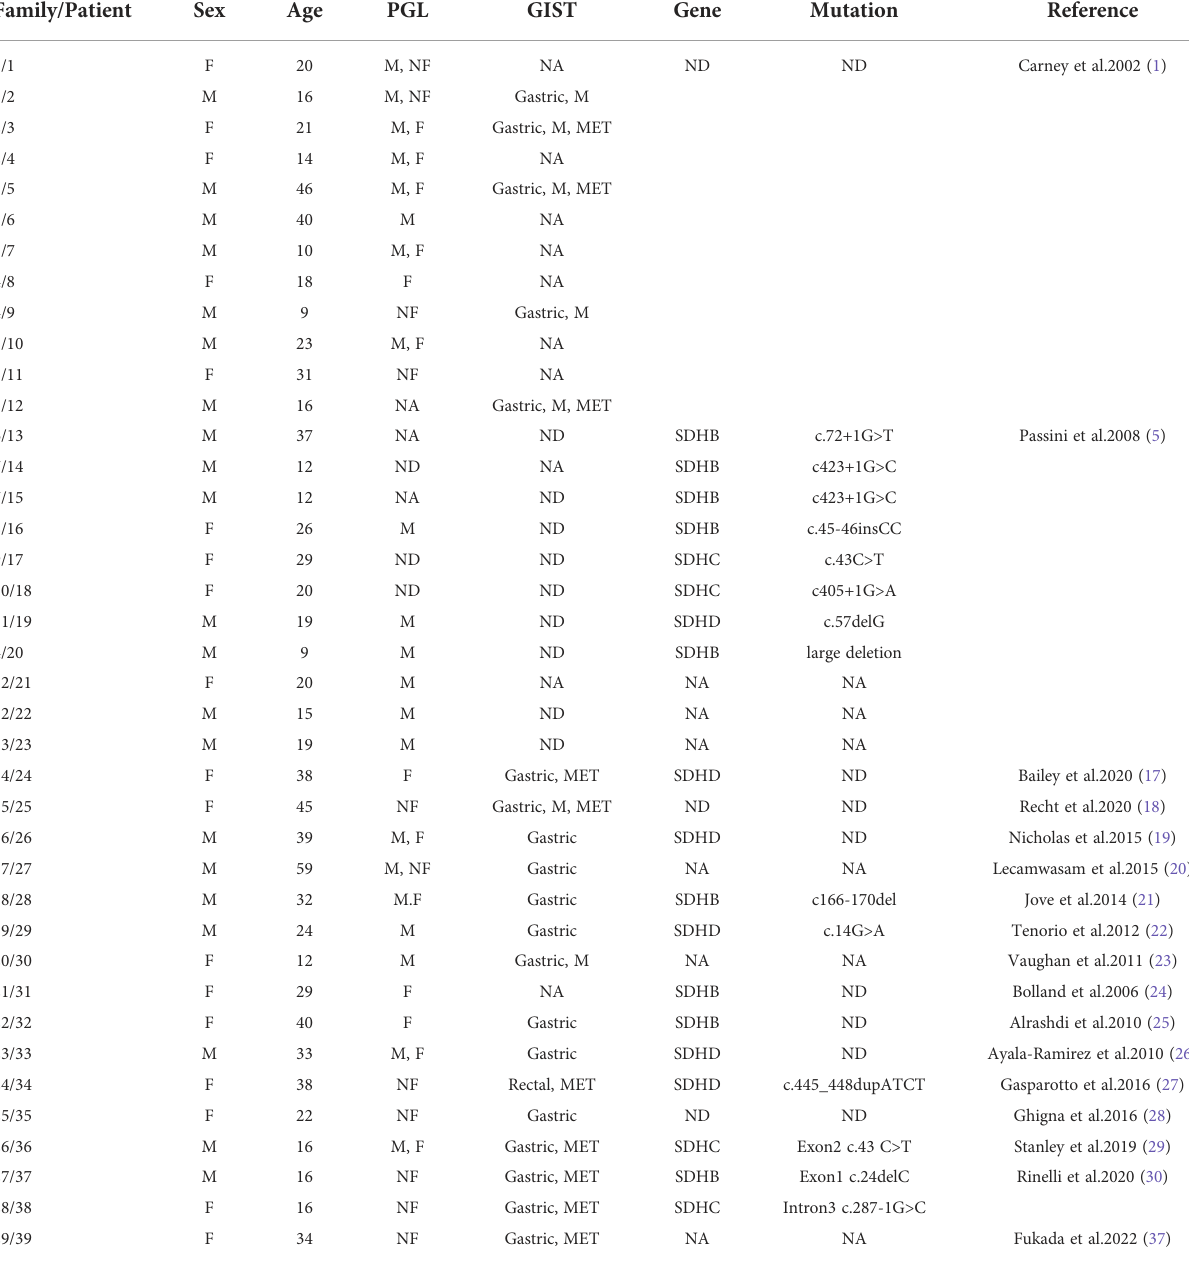
TABLE 1 Review of the Carney-Stratakis syndrome